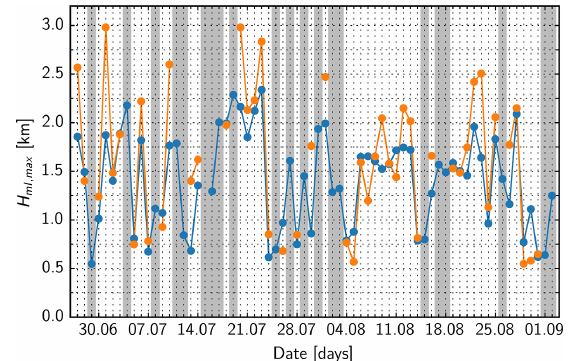
Figure 5. Mean diurnal cycle of H ml , c (dark blue) and H ml , c ± σ c as retrieved with COBOLT and H ml , v from BL-VIEW L3 (orange) at the urban background site 42, in 10min resolution, averaged over 67 days. The green line shows the growth rate of H ml , c (in kmh − 1 ).